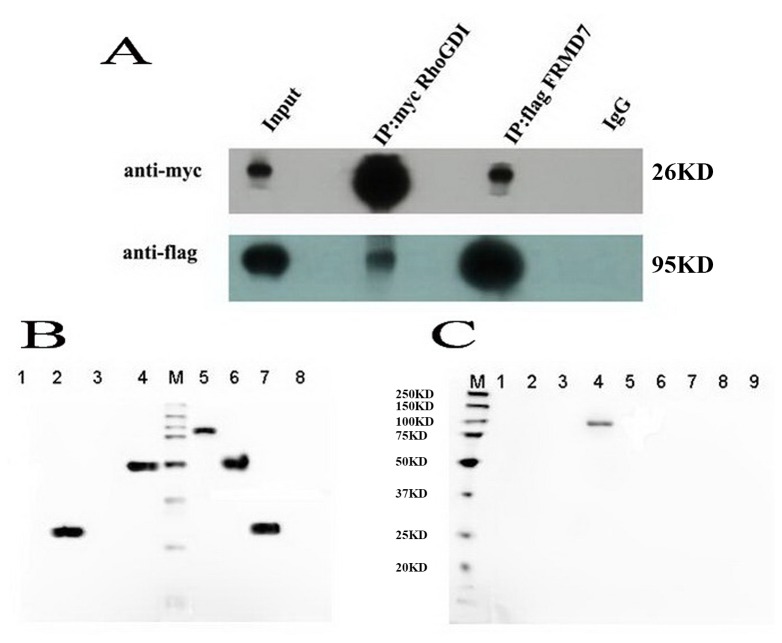
Mouse full-length FRMD7 directly interacts with RhoGDIα in vivo and in vitro.We co-transfected mouse pCMV-Myc-RhoGDIα and full-length pcDNA3.1(+)-Flag FRMD7 into Neuro-2a cells. (A) Reciprocal co-immunoprecipitation experiments showed that pcDNA3.1(+)-Flag FRMD7 co-immunoprecipitates with pCMV-Myc-RhoGDIα, and vice versa, in Neuro-2a cells. Normal mouse IgG antibody served as the negative control. (B) The prokaryotic expression of GST-RhoGDIα in DE3, and eukaryotic expression of full-length FRMD7 and truncates, Lane 1: PGEX-5X-1, -IPTG; Lane 2: PGEX-5X-1, +IPTG; Lane 3: PGEX-5X-1-RhoGDIα, -IPTG; Lane 4: PGEX-5X-1-RhoGDIα, +IPTG; M: Marker; Lane 5: FRMD7-FL; Lane 6: Cr-FRMD7; Lane 7: Nr-FRMD7; Lane 8: Empty vector. (C) In vitro GST pull down experiments, using highly purified GST-RhoGDIα recombinant proteins, where full-length FRMD7, but not Nr-ferm (aa: 1-279; the N-terminal FERM domain of the full-length FRMD7) or Cr-fragment (aa: 280-703; truncated FERM domain of FRMD7), was found to directly interact with RhoGDIα. M: marker; Lane 1: GST-RhoGDIα; Lane 2: GST-RhoGDIα+Cr-FRMD7; Lane 3: GST-RhoGDIα+Nr-FRMD7; Lane 4: GST-RhoGDIα+FRMD7-FL; Lane 5: GST- RhoGDIα+Empty vector; Lane 6: Cr-FRMD7; Lane 7: Nr-FRMD7; Lane 8: FRMD7-FL; Lane 9: Empty vector.